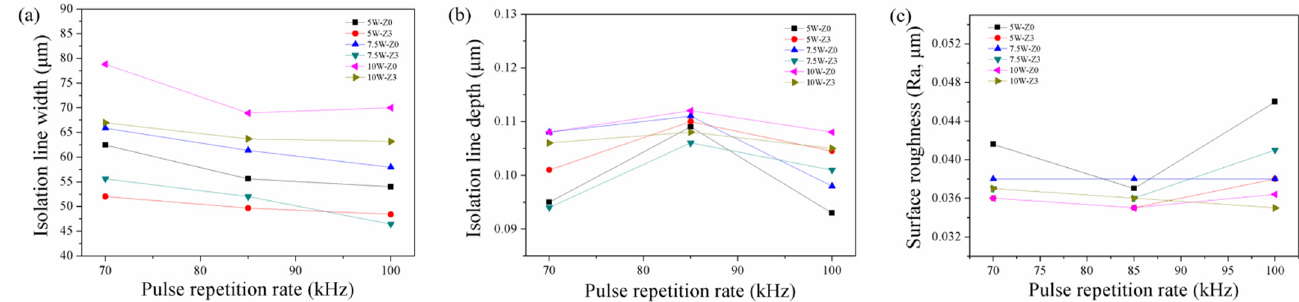
Figure 3. Relationship between the pulse repetition rate and ( a ) isolation line width, ( b ) isolation line depth, ( c ) surface roughness of PC within the isolation line.